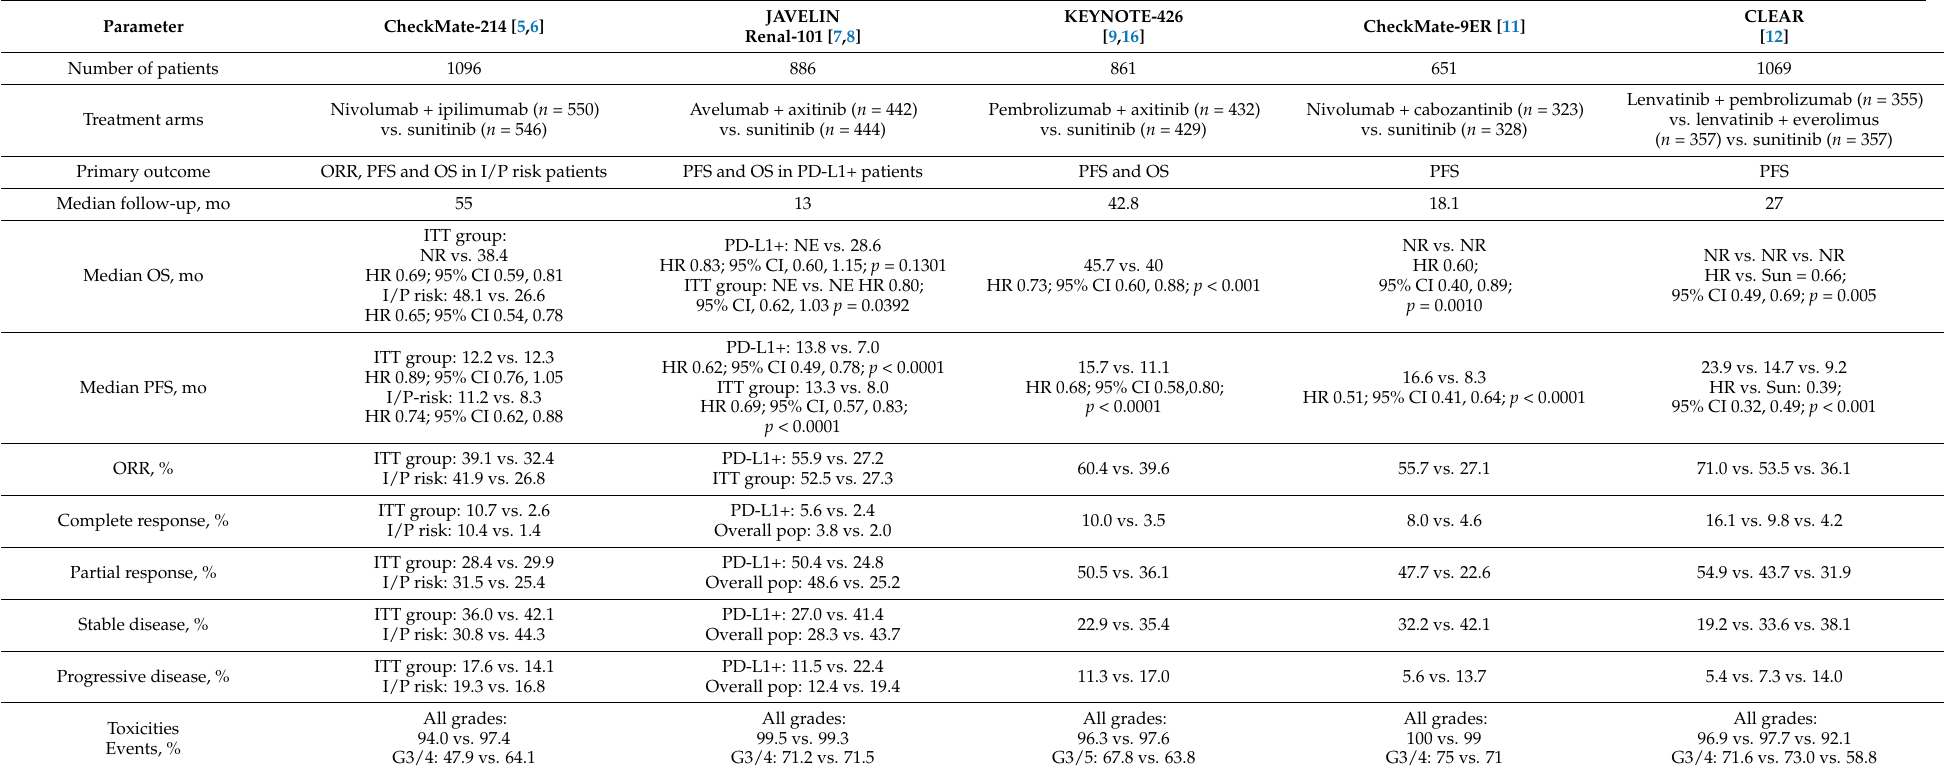
Table 1. Phase III trials of the immune checkpoint-based regimens evaluated in treatment-naïve